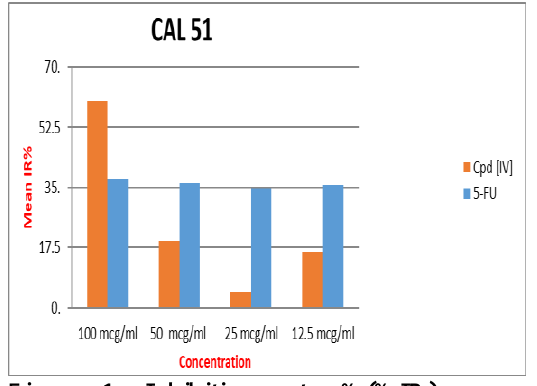
Figure 1. Inhibition rate %(%IR) versus different concentrations of compound [IV] and 5- FU, on CAL-51 cell lines at 72 hrs.